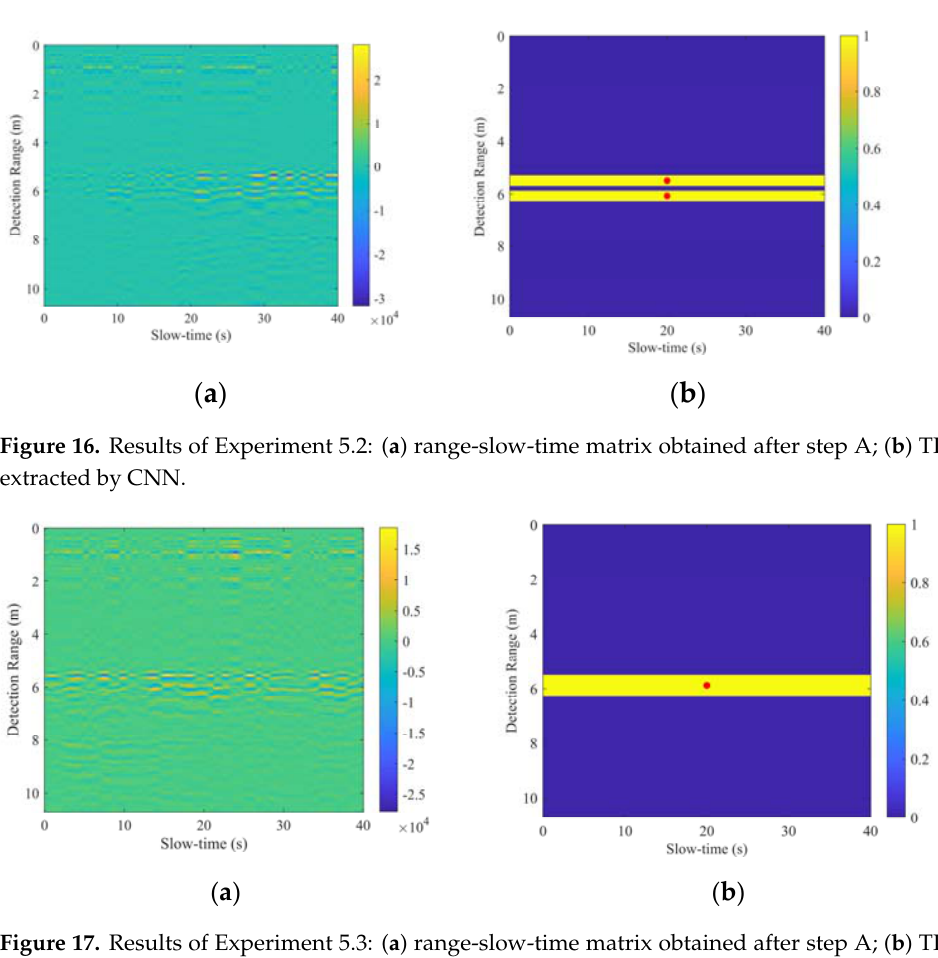
Figure 17. Results of Experiment 5.3: ( a ) range ‐ slow ‐ time matrix obtained after step A; ( b ) TPOIs extracted by CNN. Table 5. Extracted results for experiments with different target intervals.